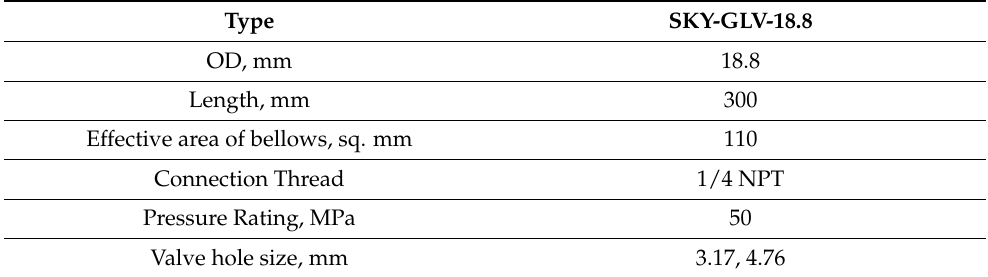
Table 3. Parameters of gas lift valve.